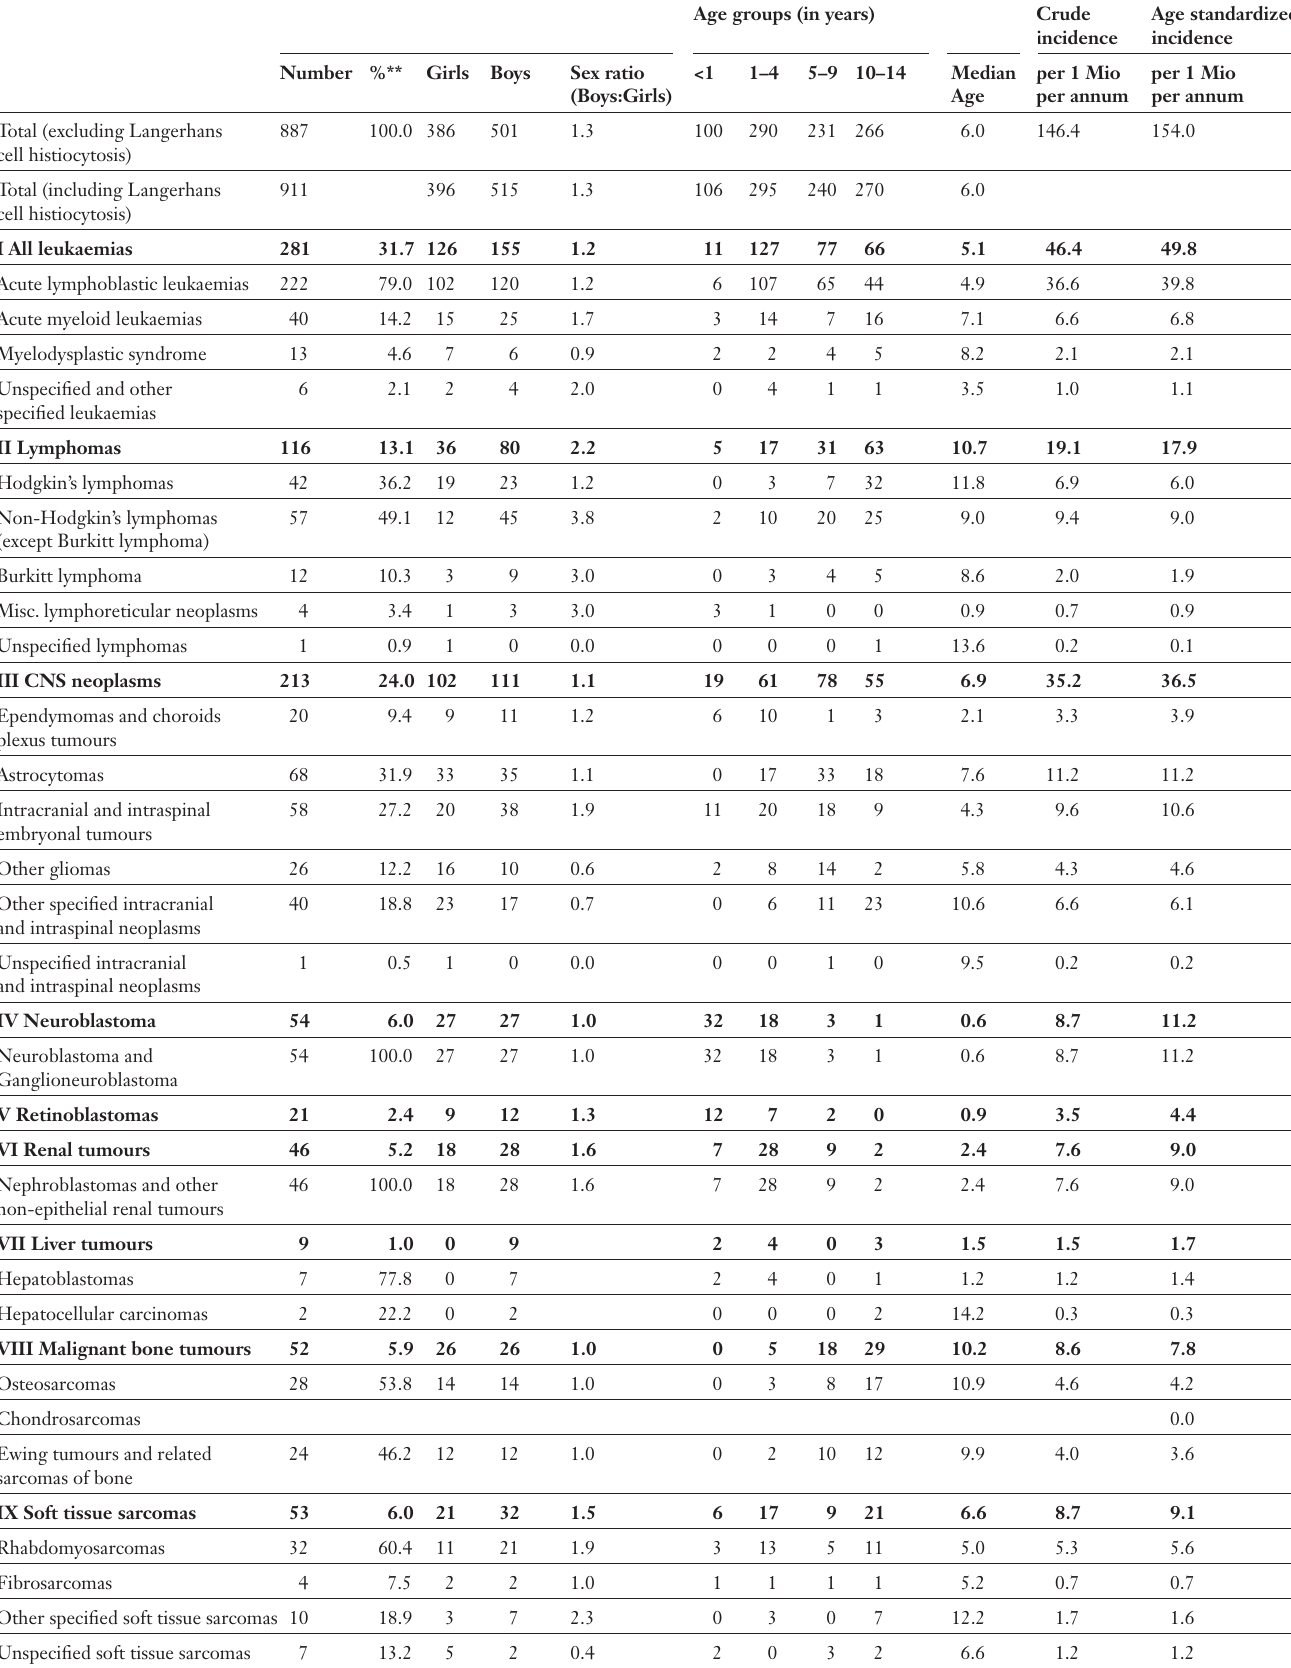
Frequencies, sex-ratios and number of cases per age-group of childhood malignancies registered in the SCCR (Swiss children below 15 years of age, diagnosed between 2001–2005 respectively; diagnoses classified according to